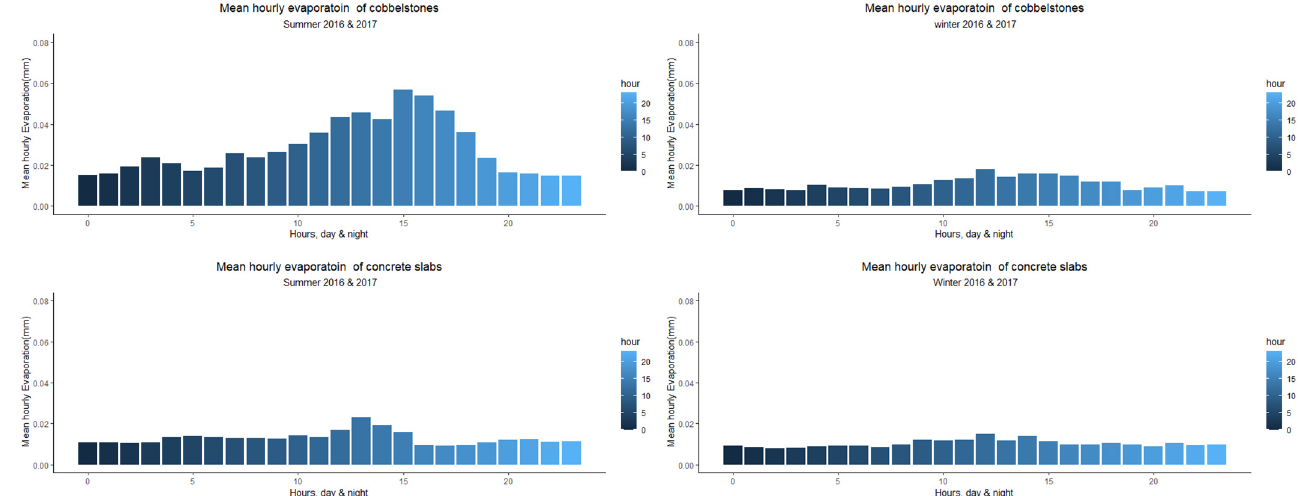
Figure 5. Mean measured hourly evaporation during day- and night-time from cobble stones and concrete slabs during summer (May to October), and winter time (November to April), mm.